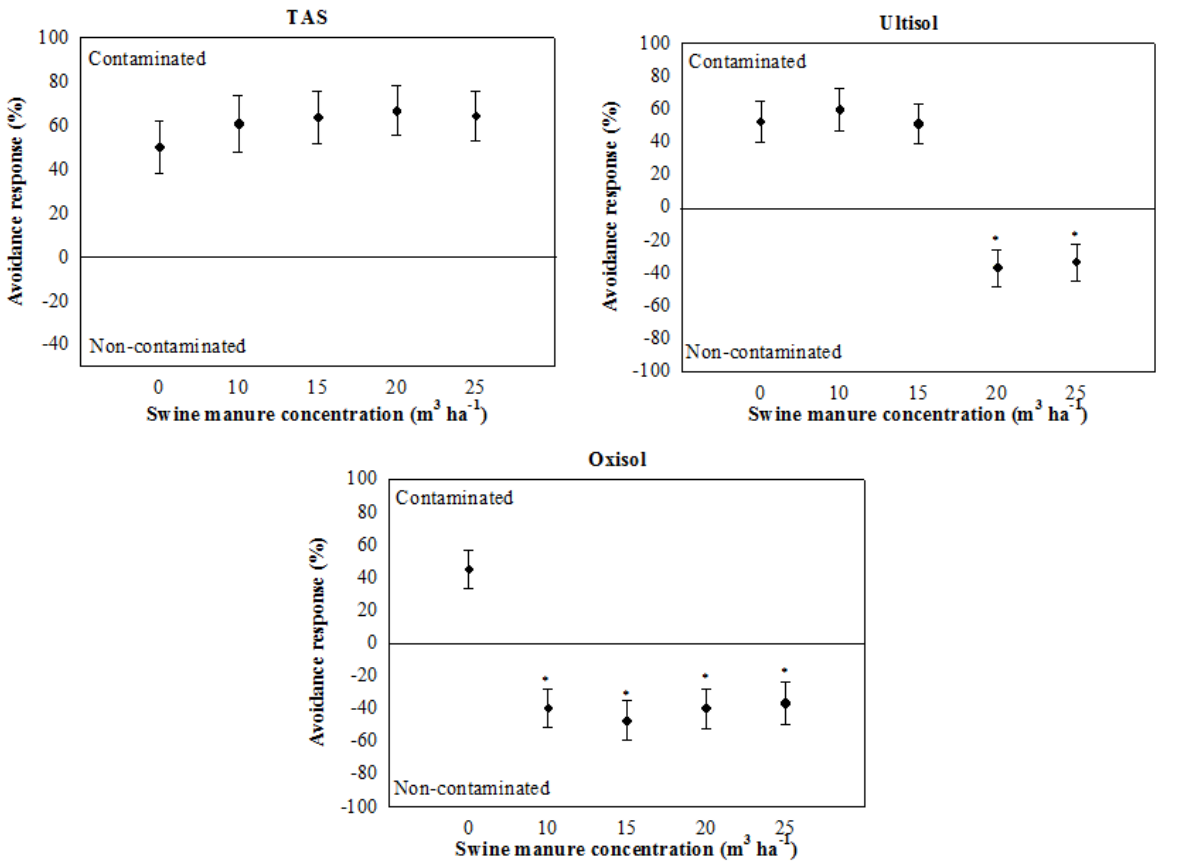
Figure 3. Avoidance response of Folsomia candida in the behavioral test with tropical artificial soil (TAS), Ultisol and Oxisol, all treated with increasing concentrations of swine manure (n = 5). *Significant statistical difference (p<0.05). Fischer exact test (n =